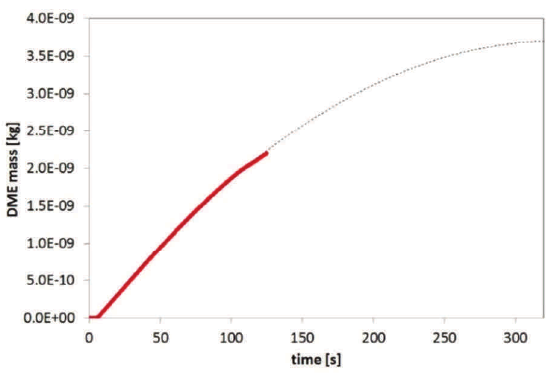
Fig. 11. DME volumetric concentration in the air, leakage variant II Low concentrations of DME in the air result from the use of an efficient ventilation system for the engine compartment (Fig. 12).